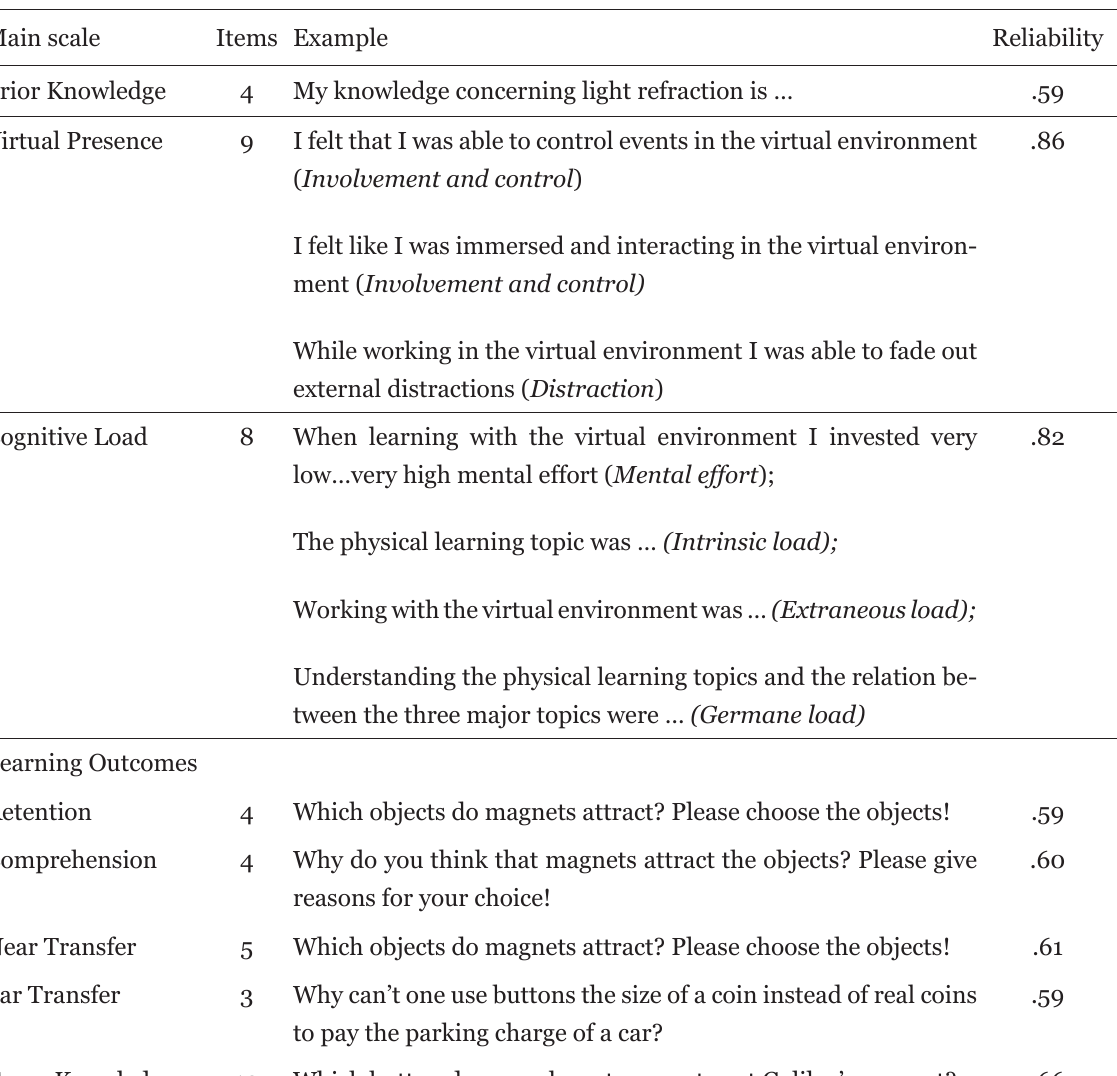
The Scales of Questionnaire and their